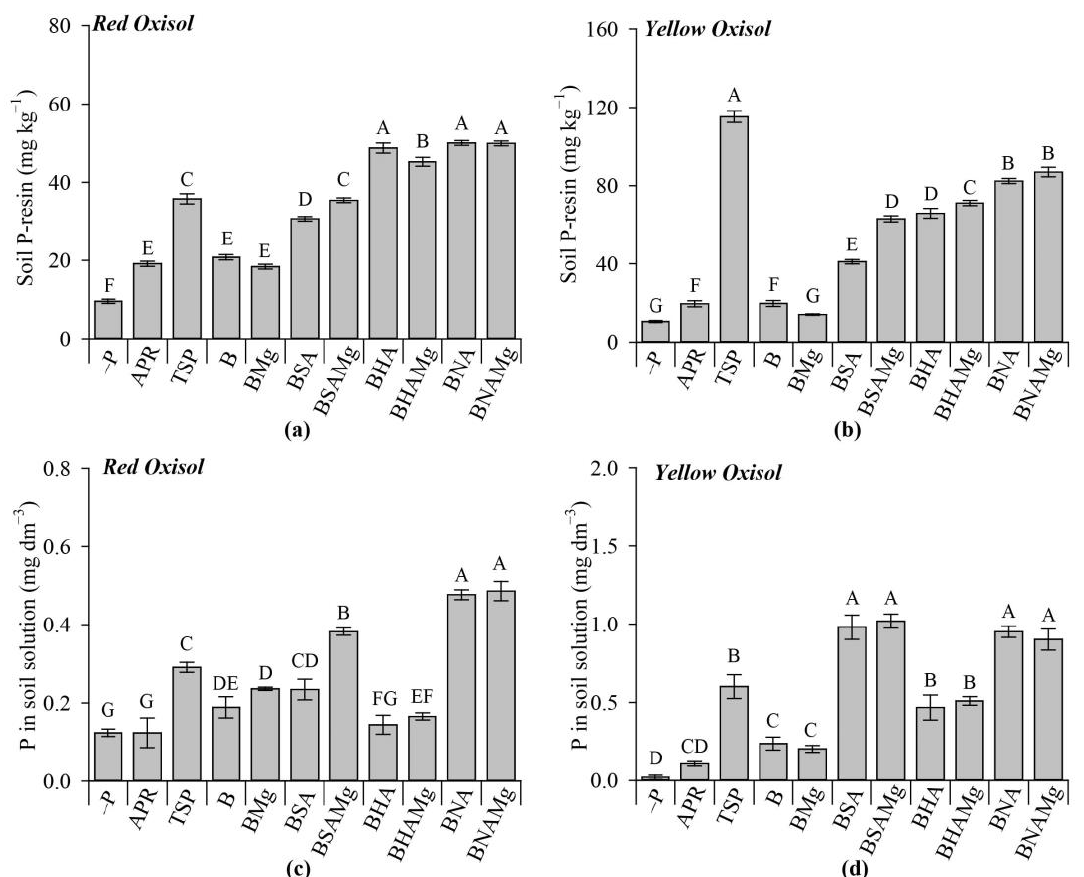
Figure 7. Residual resin P available in whole soil samples of RO ( a ), and YO ( b ), and P in solution of RO ( c ) and YO ( d ) for brachiaria grass grown in the Red and Yellow Oxisols. The bars with standard error followed by the same letter did not differ regarding the treatment mean based on the Duncan test ( p < 0.05). – P: no P fertilizer added to maize plants; TSP: triple superphosphate; APR: Arax á phosphate rock. More details of the BBFs acronyms and synthesis routes are shown in Table 1. Despite the little effect on maize growth, the BSA, BNA, and BNAMg showed positive residual effects on soil P available (resin soil test) to brachiaria biomass production (Figure